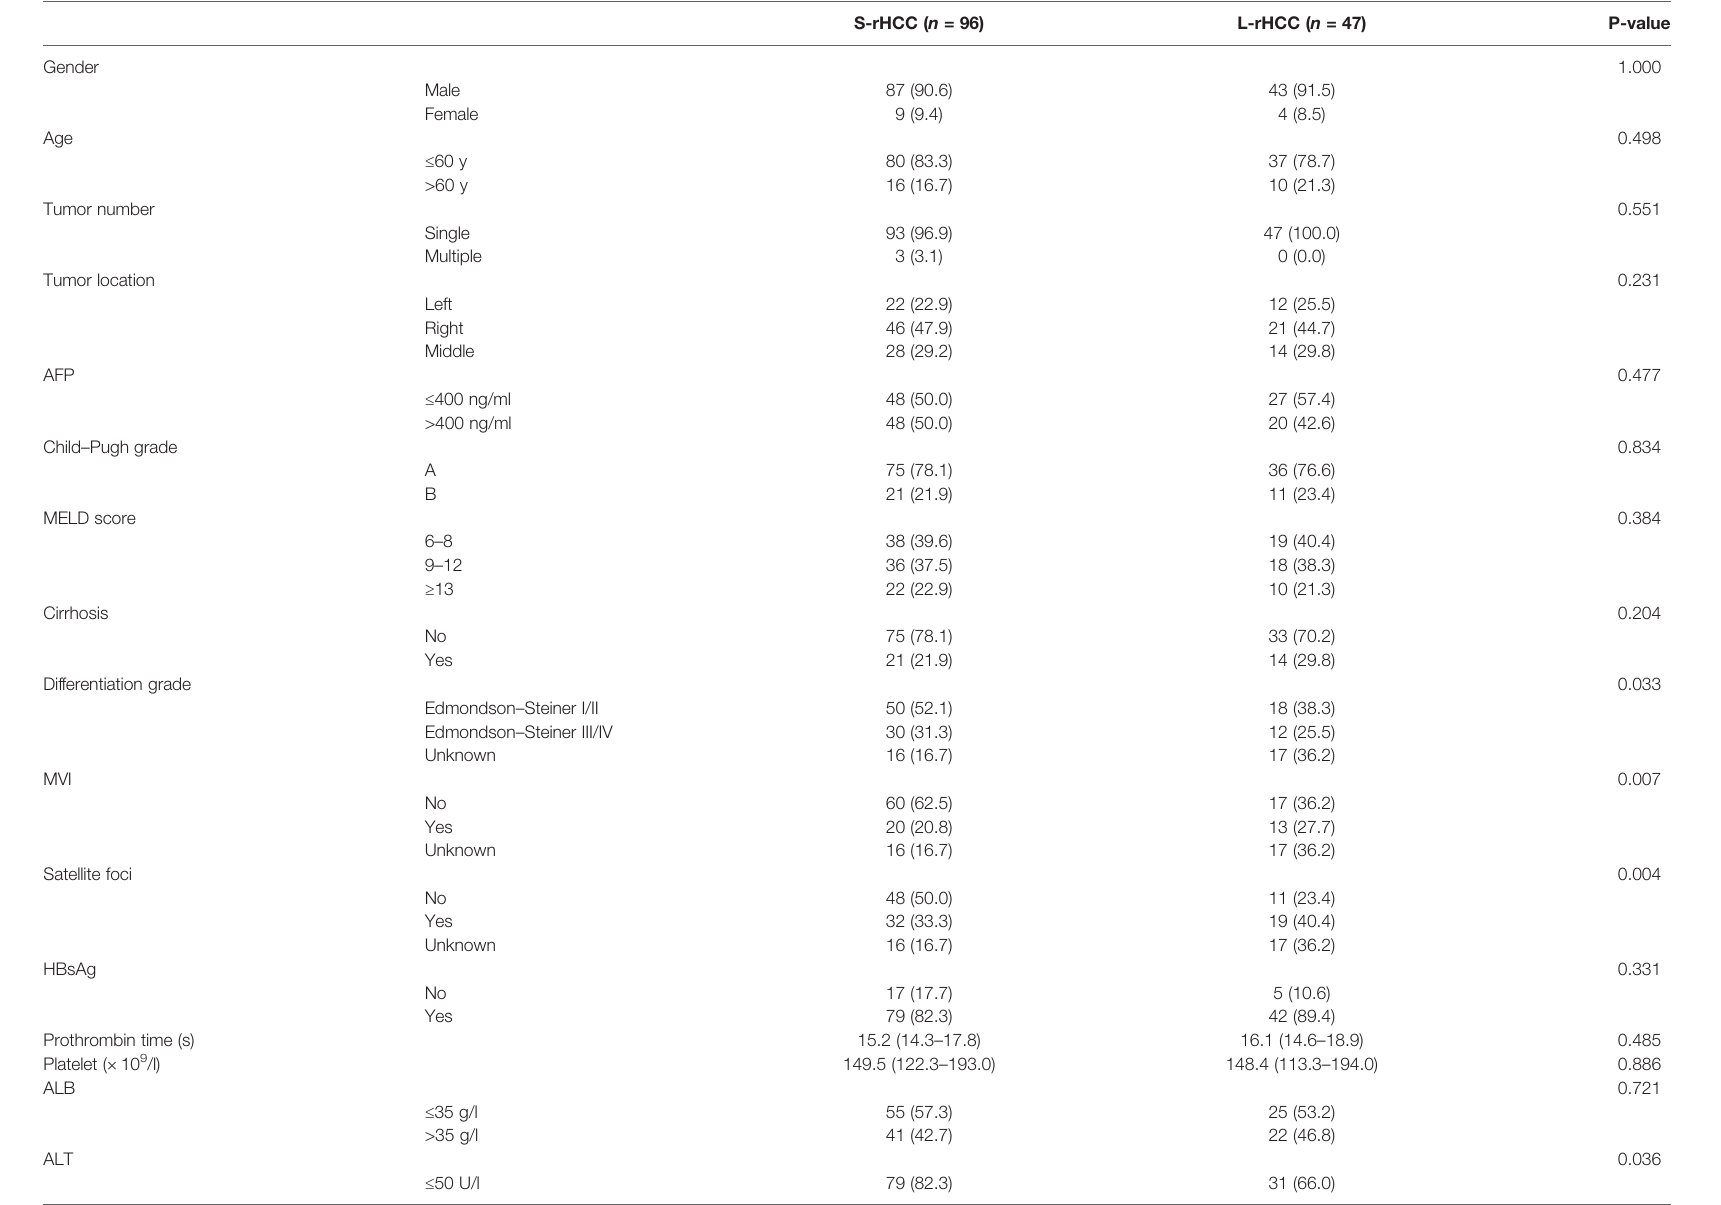
TABLE 1 | Baseline characteristics of patients with the BCLC 0/A stage in the small ruptured HCC group (S-rHCC) and large ruptured HCC group (L-rHCC) ( n